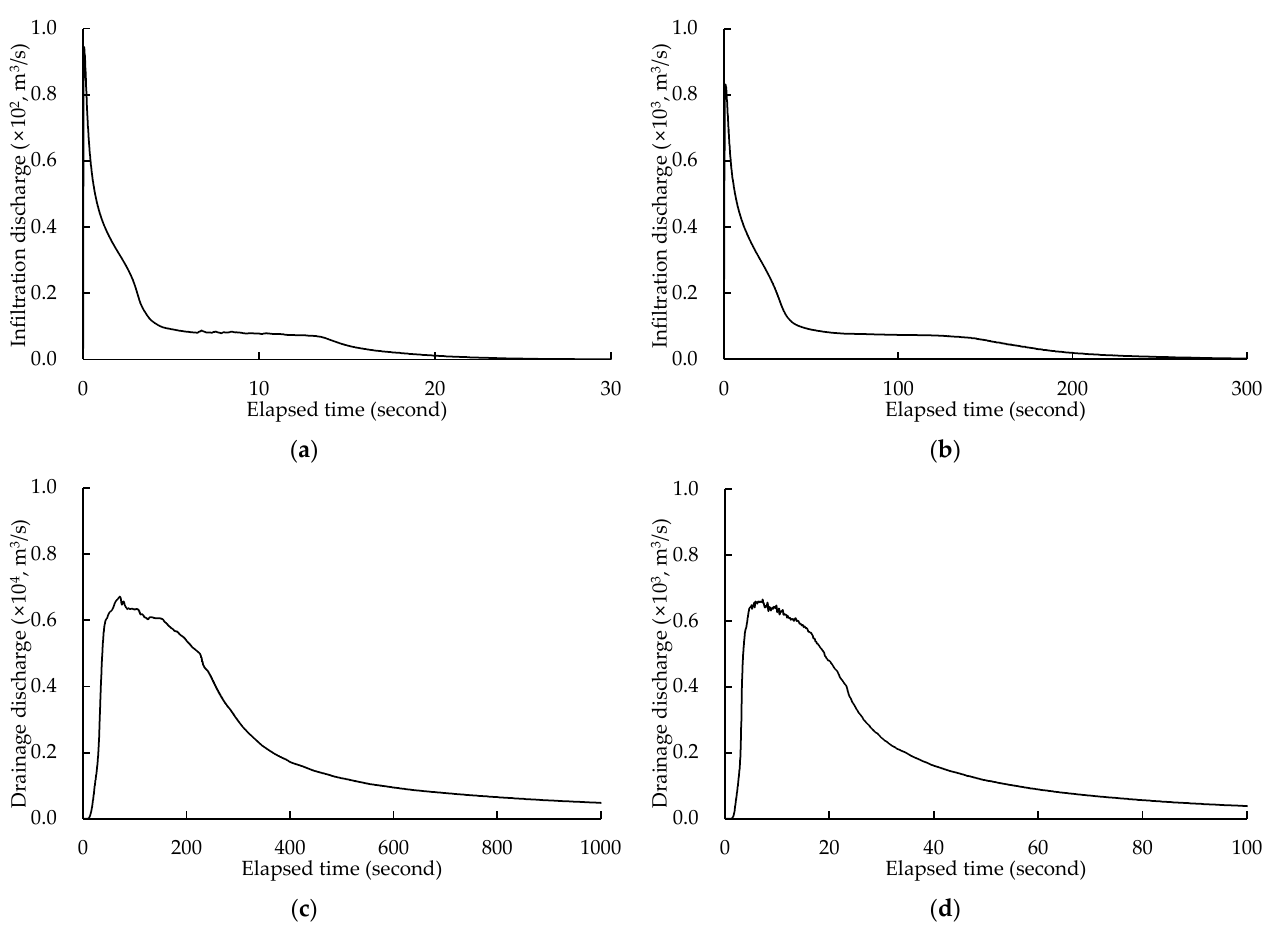
Figure 8. Results of permeability test simulation: ( a ) infiltration of case Pe-09; ( b ) infiltration of case Pe-10; ( c ) drainage of case Pe-09; ( d ) drainage of case Pe-10. Table 2. Results of permeability test model.